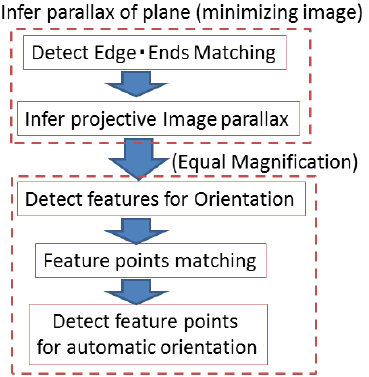
Figure 6. Processing flow of the Automatic Orientation